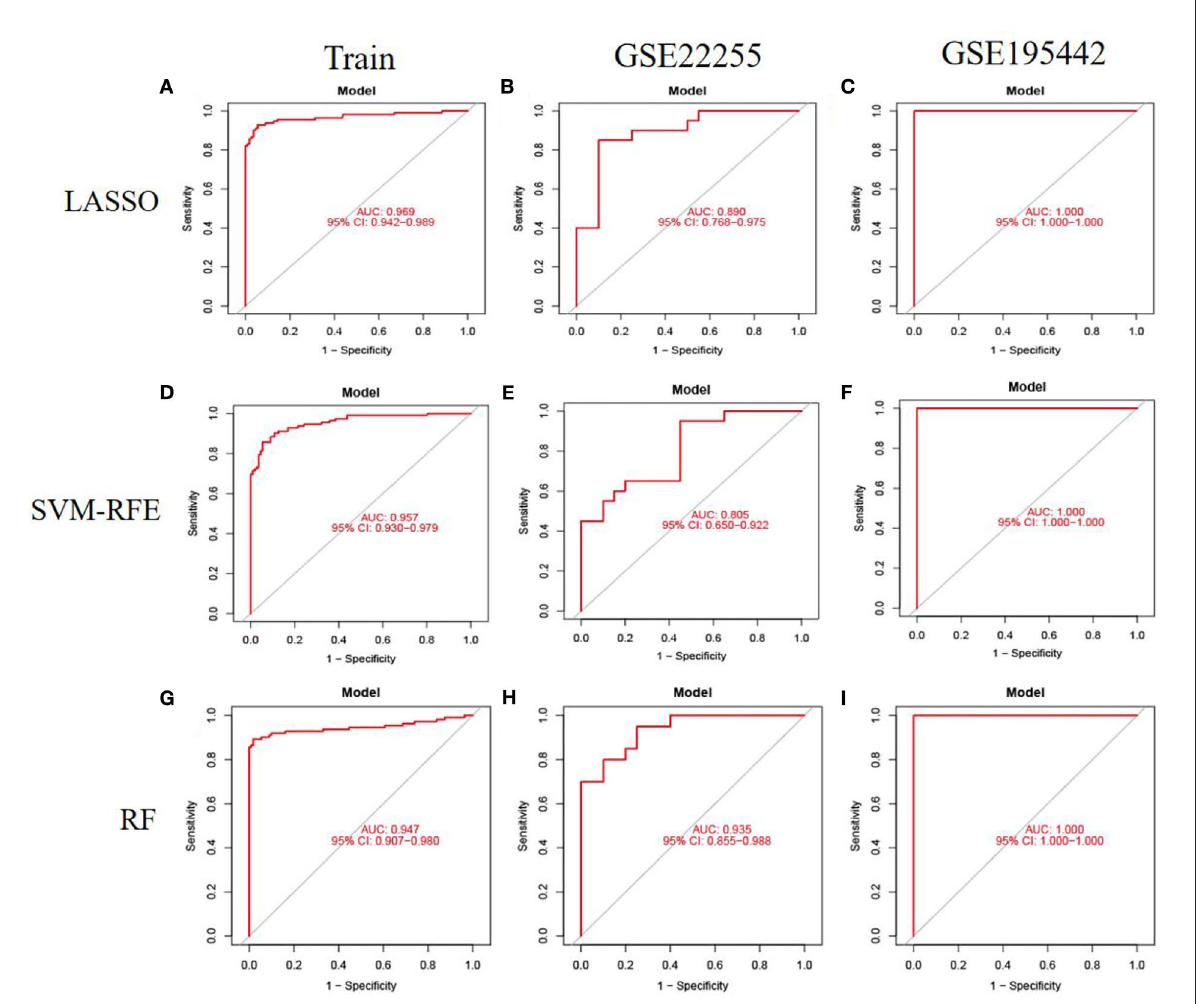
FIGURE5 Model accuracy evaluation. (A–C) The ROC curves for using LASSO to estimate accuracy in training, GSE22255, and GSE195442 datasets. (D–F) The ROC curves for using SVM-RFE to estimate accuracy in training, GSE22255, and GSE195442 datasets. (G–I) The ROC curves for using RF to estimate accuracy in training, GSE22255, and GSE195442